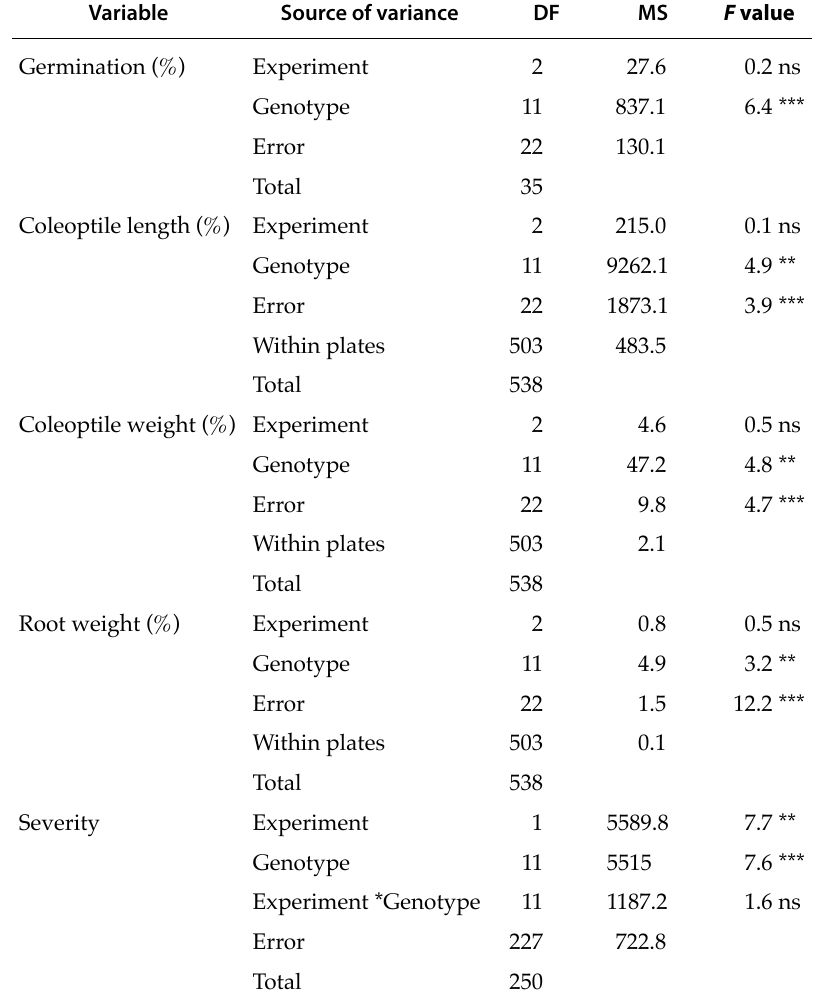
Table 4. Analysis of variance (ANOVA) of seedling variables (% of control) and disease severity (% symptomatic spikelets/ spike) of 12 wheat genotypes after inoculation with Fusarium graminearum